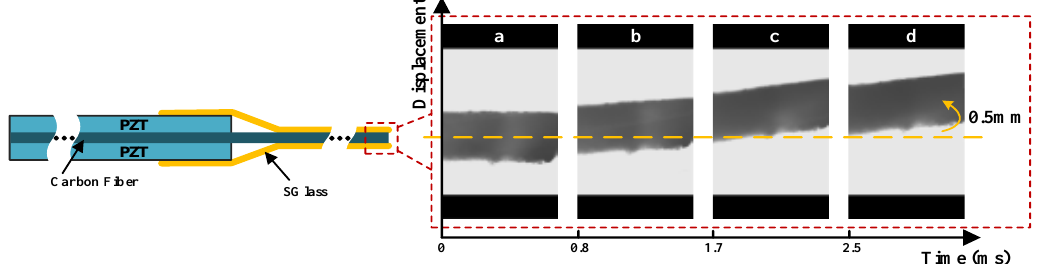
Figure 20. Displacement images of the piezoelectric actuator driven at four different voltages: ( a ) 0 V; ( b ) 60 V; ( c ) 80 V; and ( d ) 100 V.